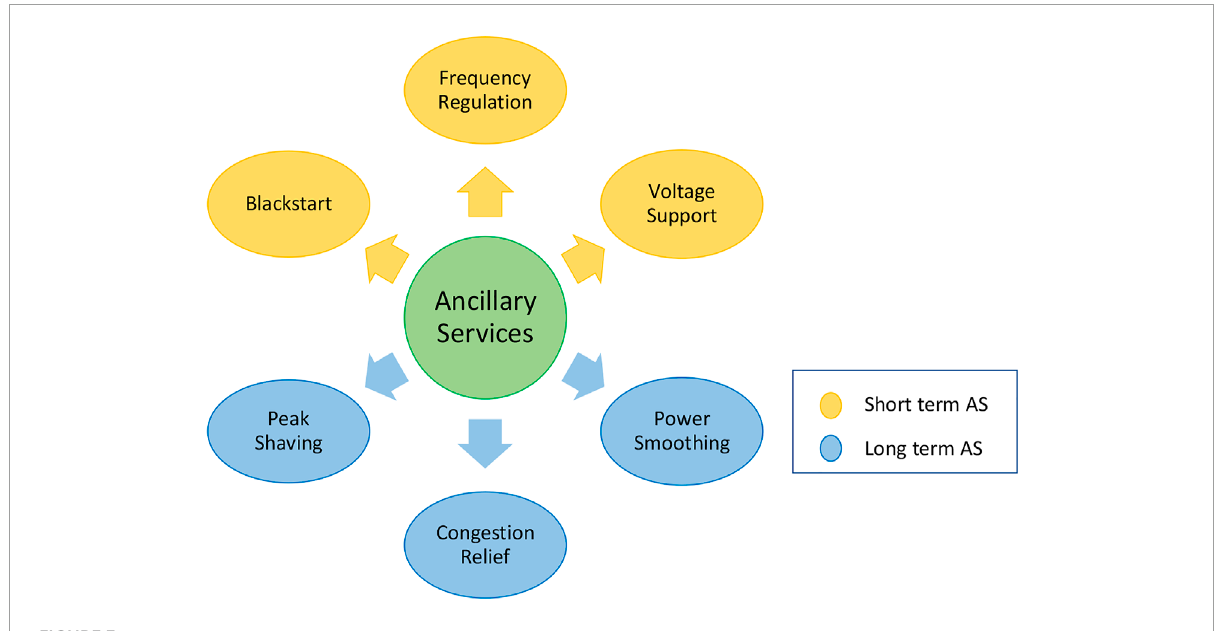
FIGURE 3 Types of ancillary services for power